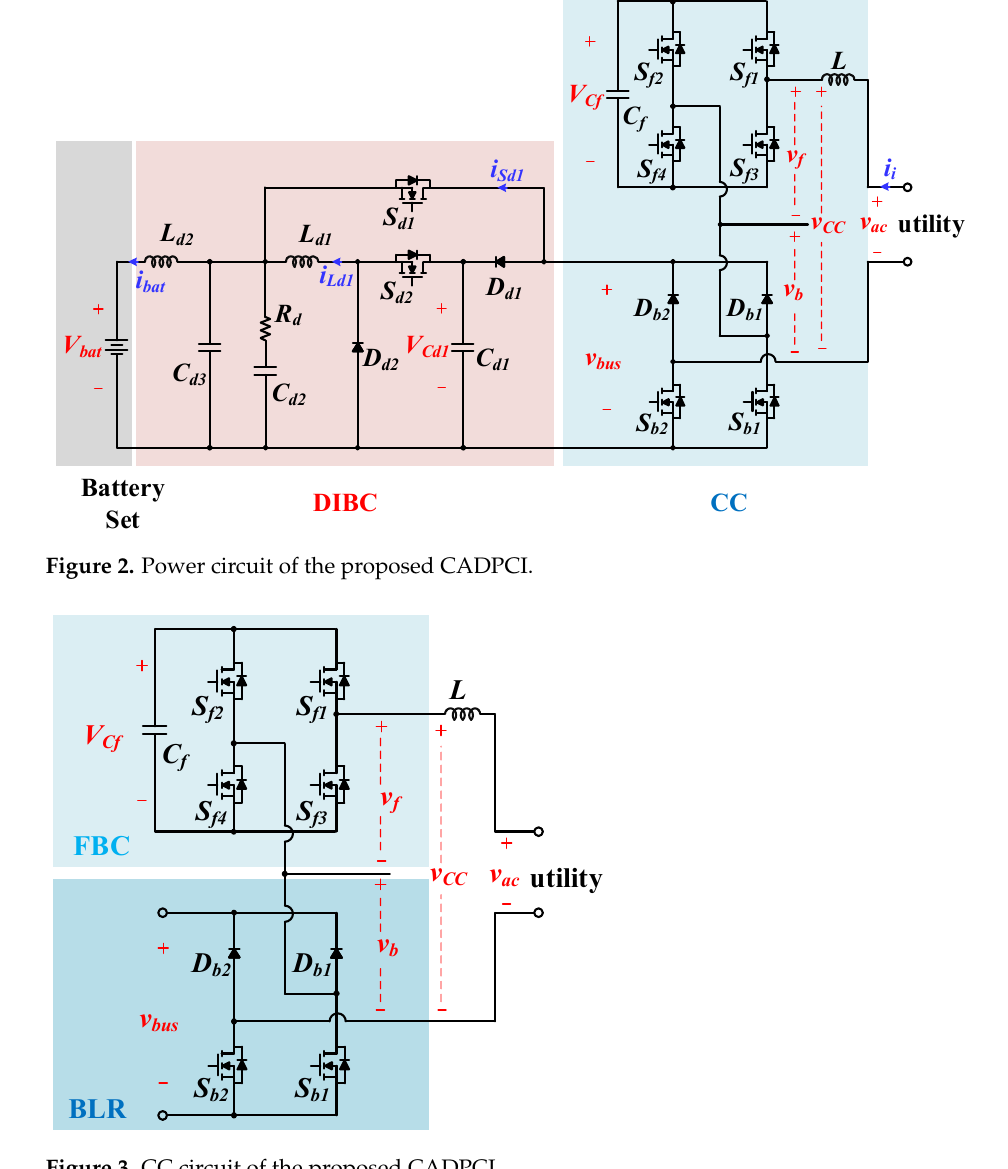
Figure 3. CC circuit of the proposed CADPCI.